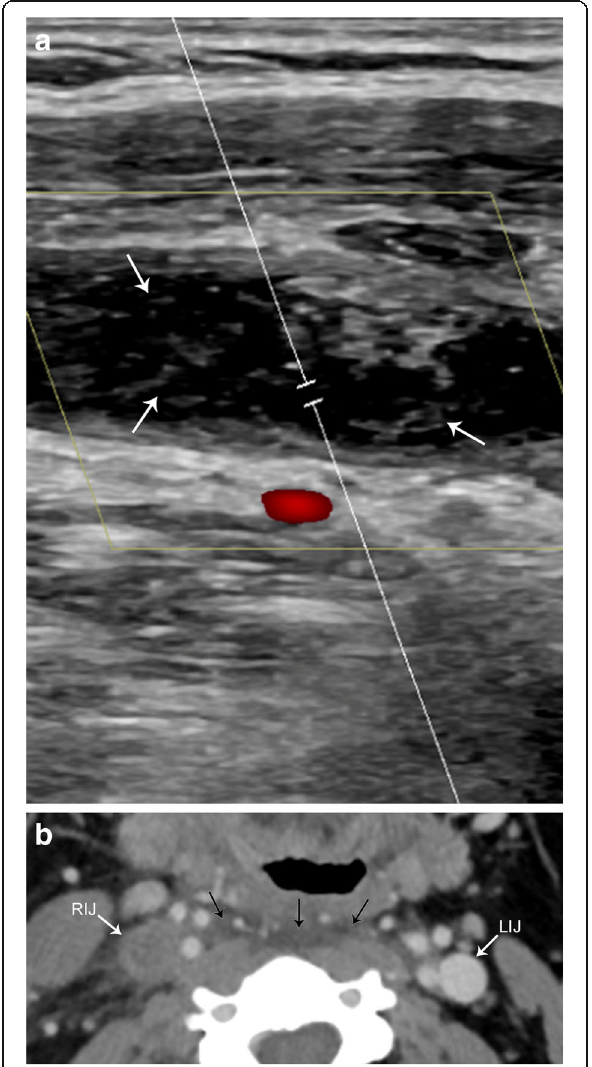
Fig. 18 Acute jugular vein thrombosis. a Sagittal color flow Doppler ultrasound image demonstrates an occlusive hypoechoic thrombus (arrows) within the jugular vein. There is an absence of color fill within the vessel. b Axial contrast-enhanced CT image shows an expanded and non-enhancing right internal jugular vein (RIJ). Compare to the normal left internal jugular vein (LIJ). Note the retropharyngeal fluid (arrows), a common finding with acute jugular venous thrombosis